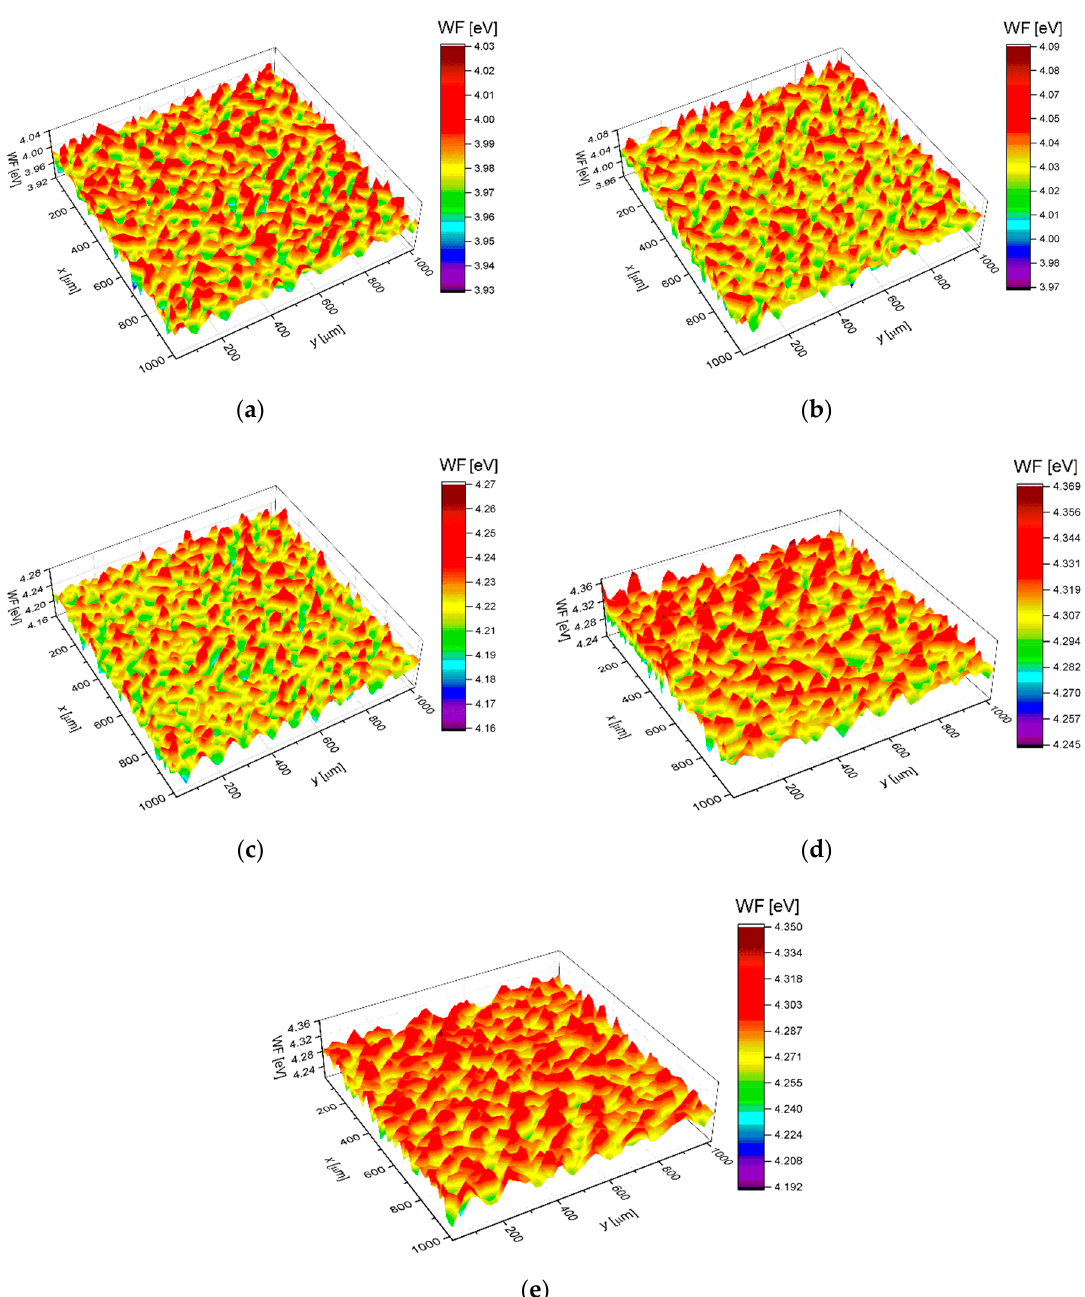
Figure 11. Surface distribution map of the work function for the sandblasted Ti G4: ( a ) Before autoclaving; ( b ) After autoclaving for 30 min; ( c ) After autoclaving for 60 min; ( d ) After autoclaving for 90 min; ( e ) After autoclaving for 120